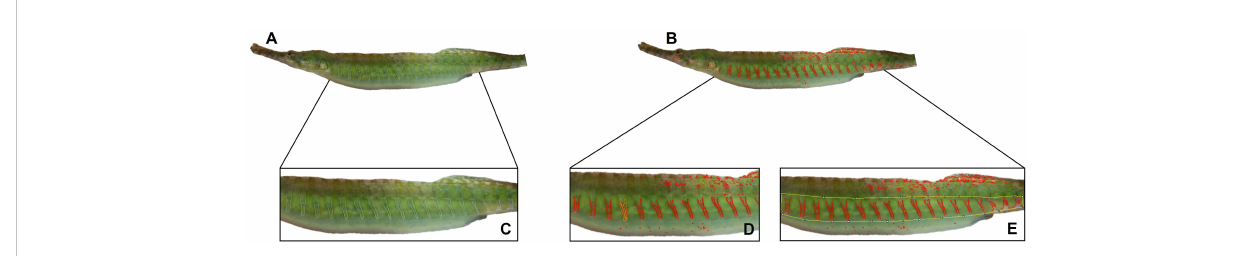
FIGURE 1 (A) Photos of the iridescent bands found on female S. scovelli and (B) the corresponding iridescent signal that is highlighted by the Iridescence Detection and Isolation Algorithm (IDIA). (C) represents the area of the torso that possesses the iridescent bands while (D, E) show the two ways of quantifying iridescence though using the IDIA and ImageJ (mean band iridescence and overall iridescence